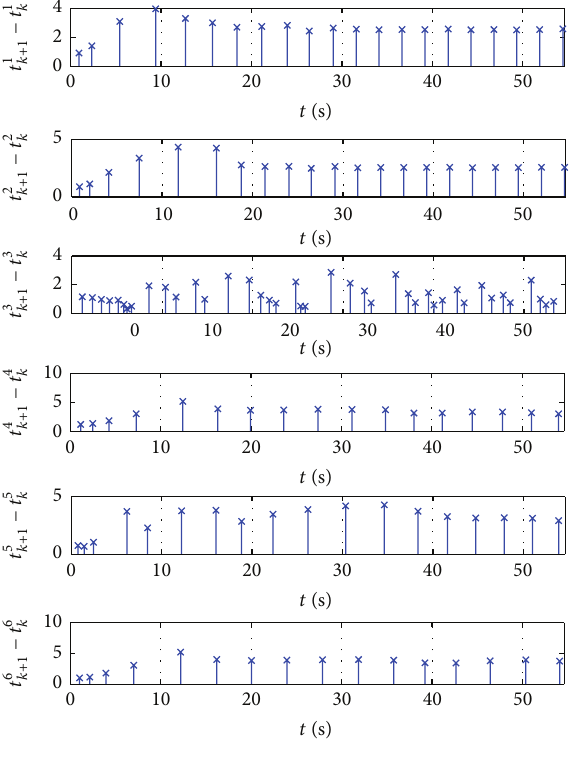
Figure 5: Event instants and time intervals of